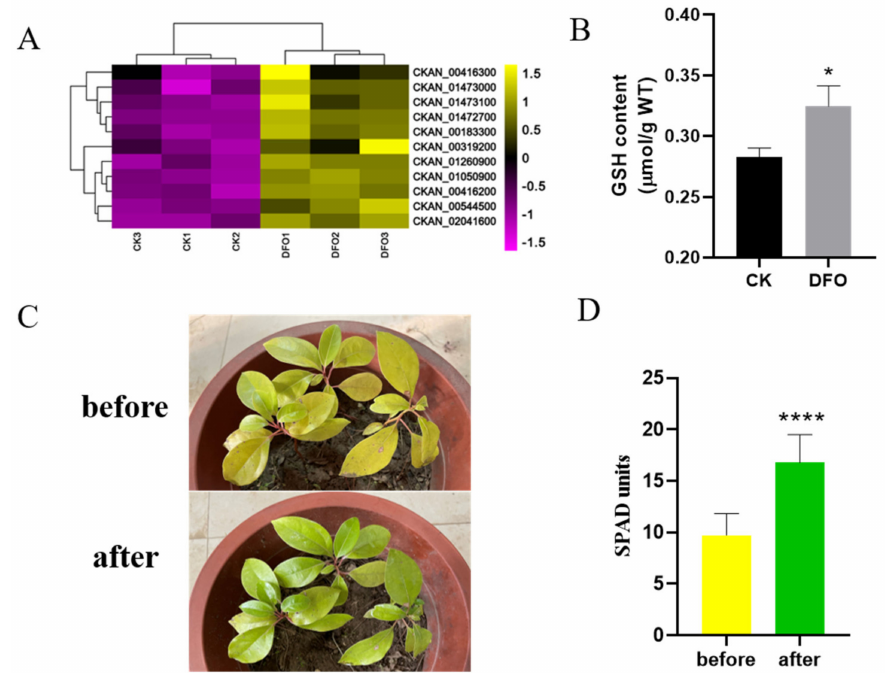
Figure 5. GSH alleviates the DFO − mediated iron deficiency response in C. camphora . ( A ) Gene expression analysis of the GSH metabolic pathway with and without DFO supplementation, ( B ) comparison of the endogenous GSH content, ( C , D ) phenotype and SPAD value of C. camphora before and after exogenous spraying of 1 µ M reduced GSH. Bars represent the standard error ( n ≥ 3). * and **** represent significant differences at p < 0.05 and p < 0.0001 ( t -test),